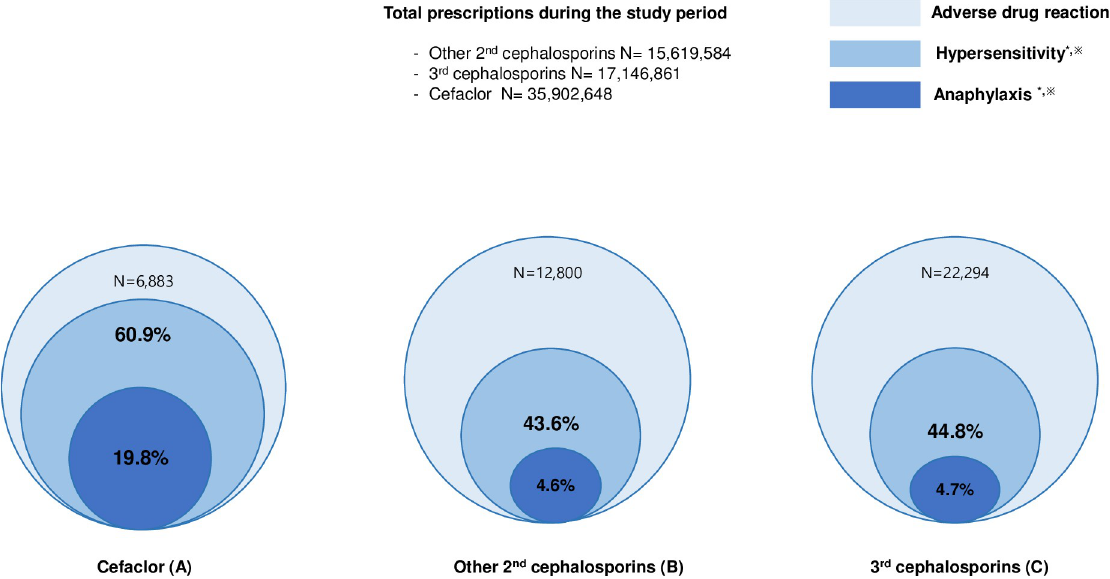
Fig 2. Proportions of hypersensitivity and anaphylaxis among adverse drug reactions to cefaclor (A), other 2 nd cephalosporins (B), and 3 rd cephalosporins (C). � P < 0.001 (other 2 nd cephalosporins vs. cefaclor). ※ P ^ < 0.001 (3 rd cephalosporins vs. cefaclor).